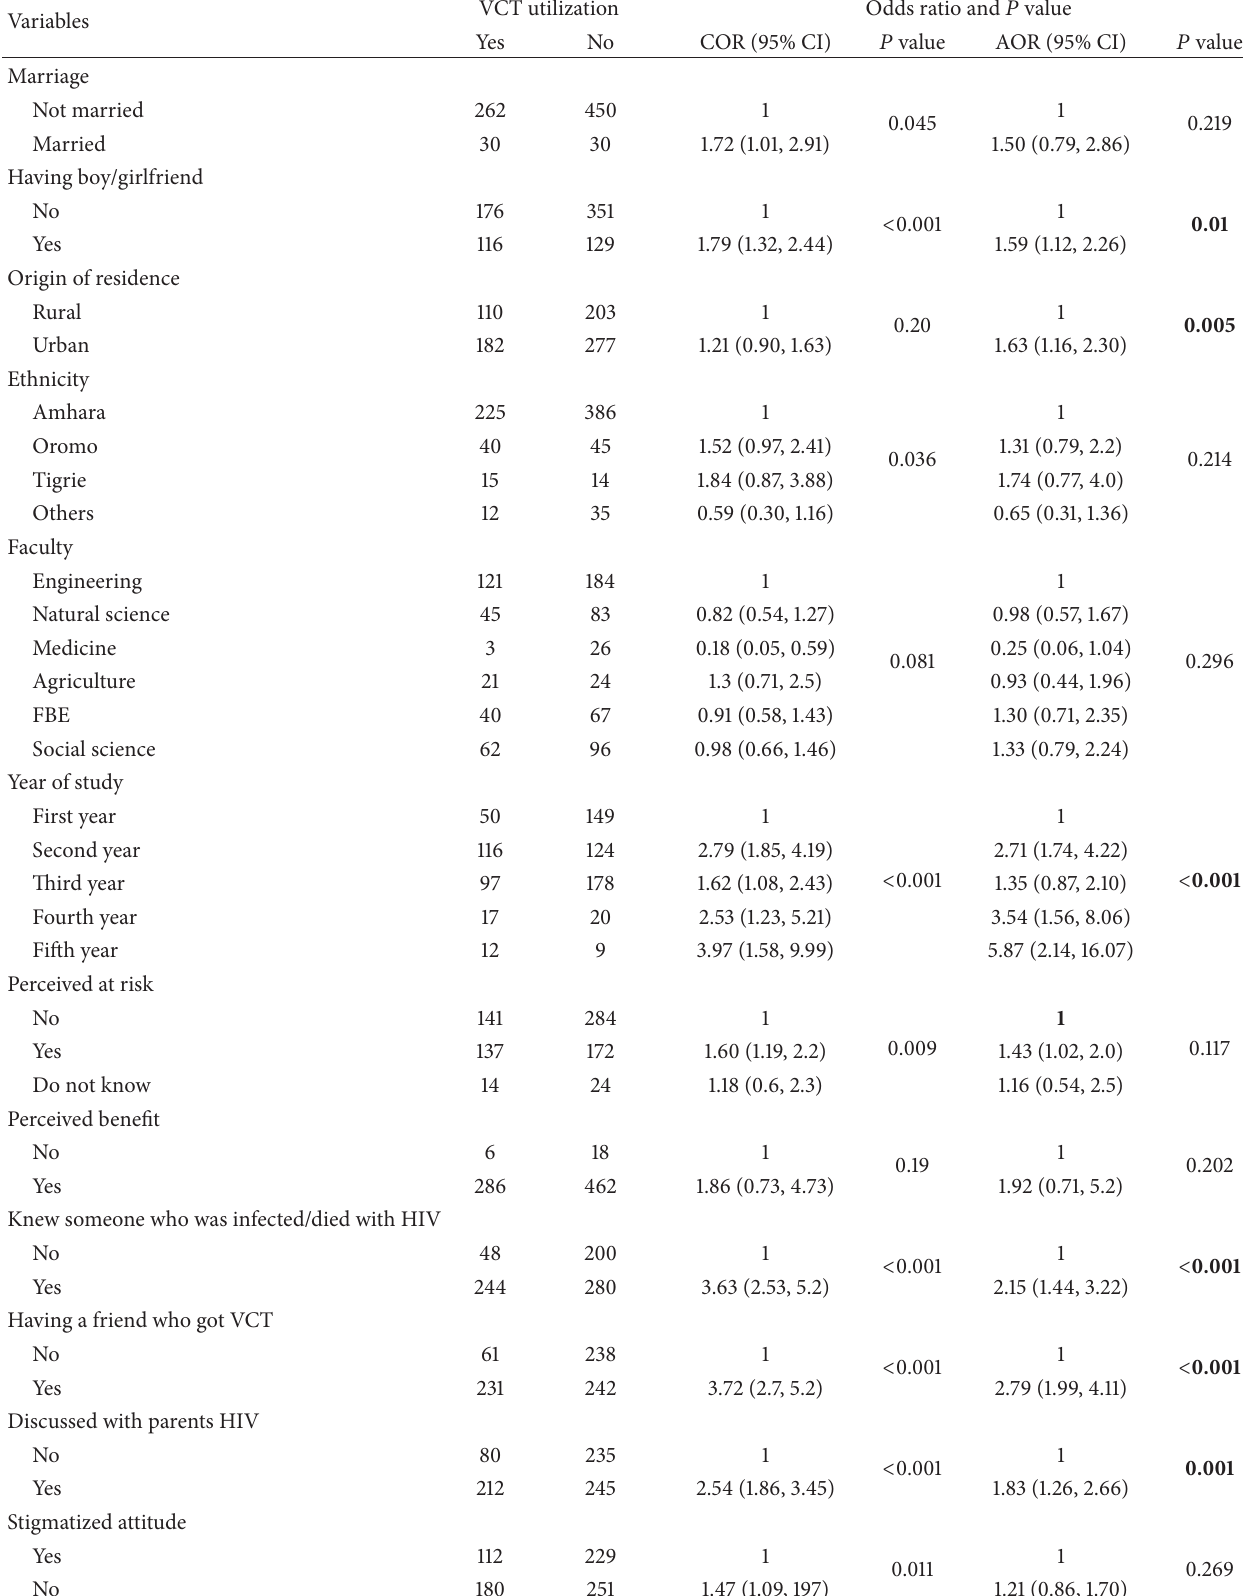
Table 2: Factors associated with VCT uptake, BDU, April